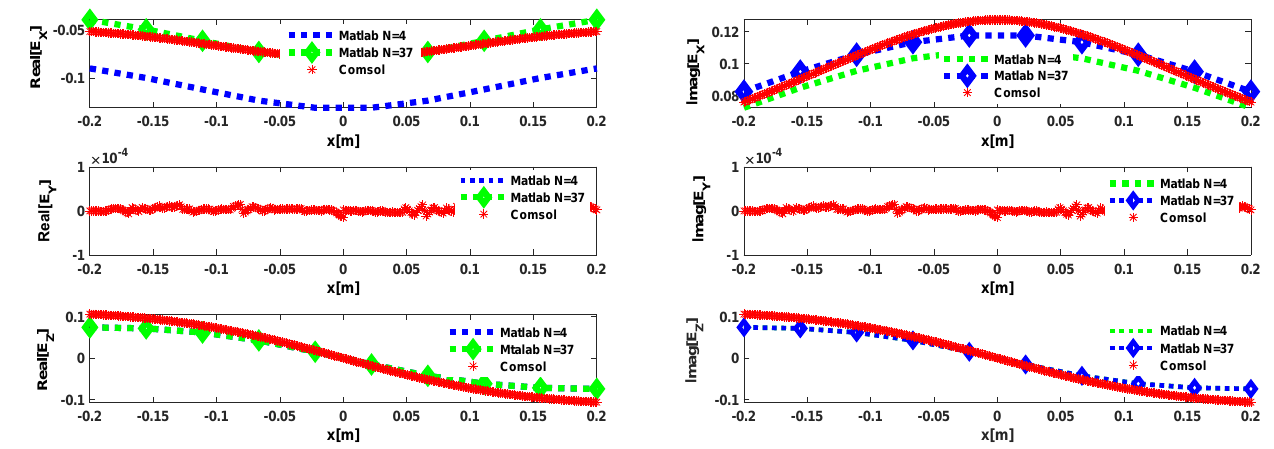
Figure 6. Real part ( left ) and imaginary part ( right ) of the scattered electric field by two PEC spheres. The red color lines (Comsol results), blue and green lines (Matlab results) at different value of the truncation sum N , sphere I, and sphere II are translated at 0.4 m and − 0.4 m along z -axis, and the selected frequency is f = 0.3 GHz.